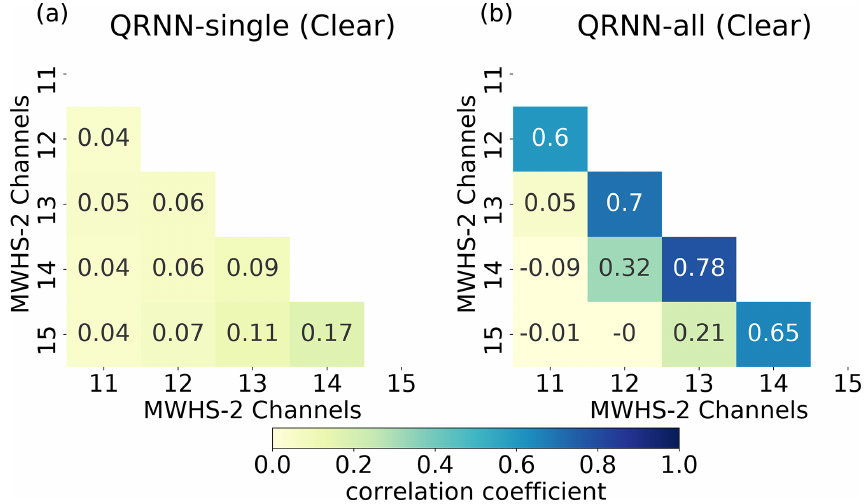
Figure 5. The triangular error correlation matrix obtained from (a) QRNN-single and (b) QRNN-all for MWHS-2. The label “Clear” repre- sents cases with cloud impact less than